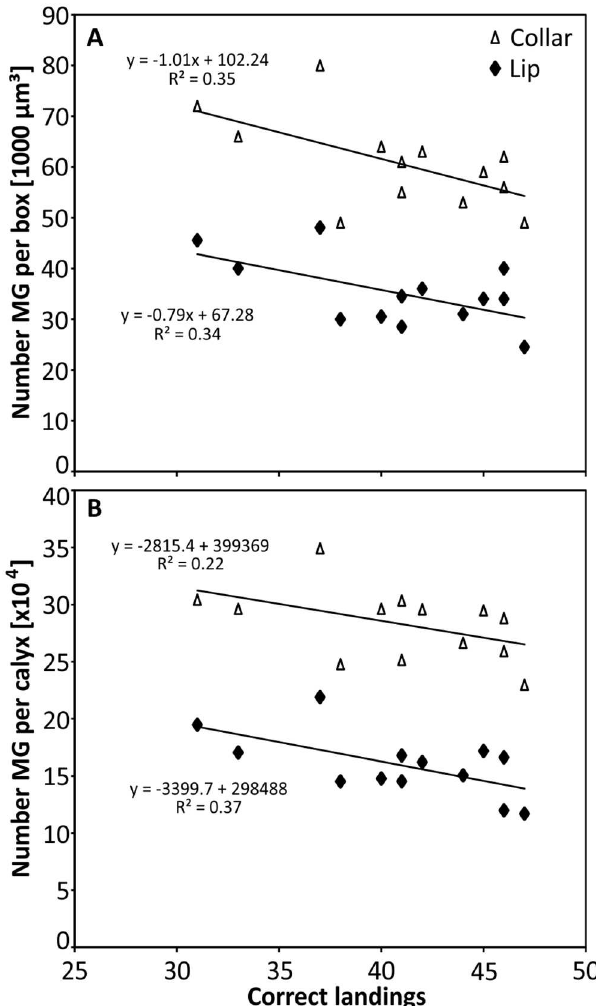
Fig 6. Correlation between numbers of microglomeruli (MG) and numbers of correct landings in absolute conditioning experiment. Evidence for a correlationbetween the absolute number of correct landings(from a total of 50 decisionsduring color conditioning) and an individual’s MG number in both calyx subregions, the lip and the dense collar. Average number of MG per 1000 μ m 3 cube ( A ) and extrapolated to whole volume ( B ). N =